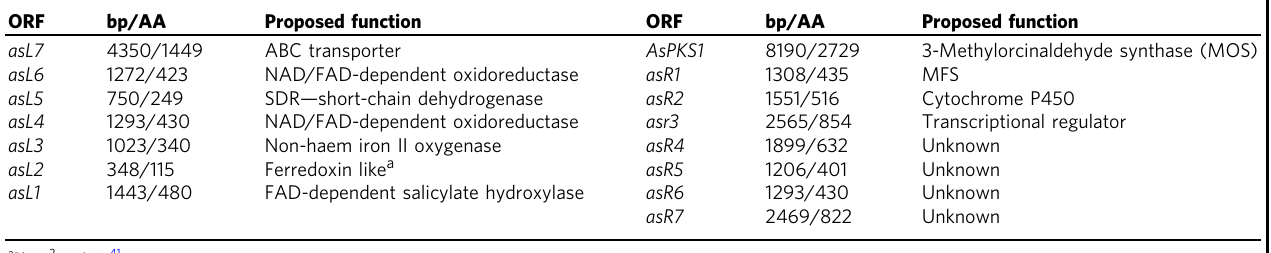
Table 1 Annotation of genomic region surrounding aspks1